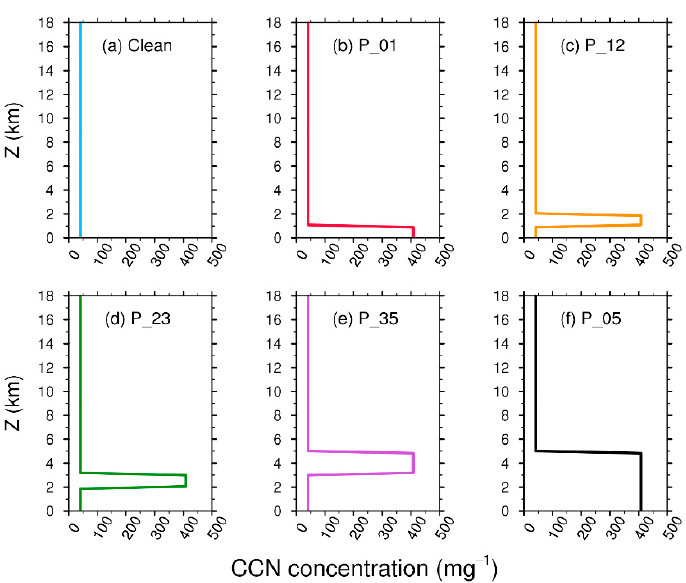
Figure A1. The initial vertical profiles of the number concentrations of aerosols that serve as cloud condensation nuclei used at model initialization in the ( a ) Clean, ( b ) P_01, ( c ) P_12, ( d ) P_23, ( e ) P_35 and ( f ) P_05 simulations respectively. Note the unit of concentration is changed to ‘mg − 1 ′ for a more intuitive comparison.